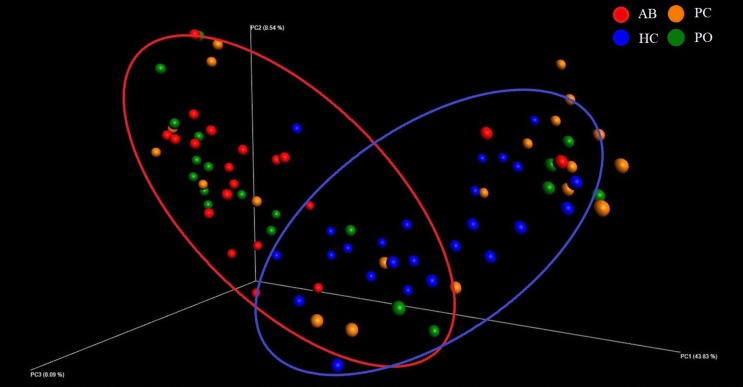
Beta diversity analysis based on UniFrac analysis. Plots were generated using weighted UniFrac distances. Red dot represents the abscess pus (AB) group. Green dot represents the pocket (PO) group. Yellow dot represents the patient control (PC) group. Blue dot represents the healthy control (HC) group. Circles in red and blue represent different periodontal bacterial community clusters, respectively.